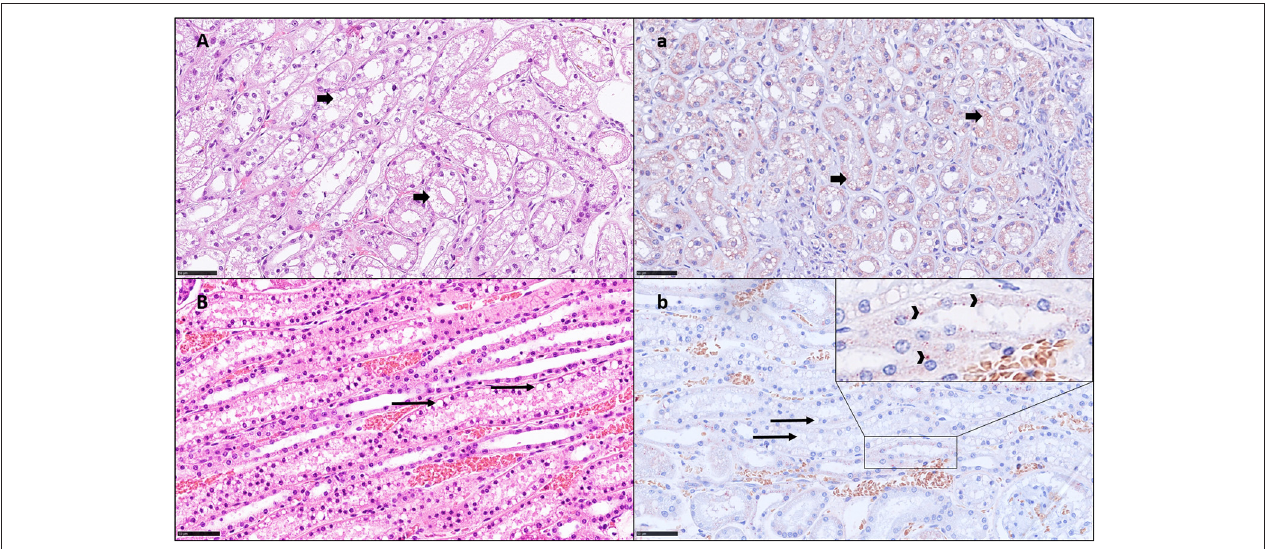
FIGURE 1 | HE histology (A,B) and immunohistochemistry for HES (a,b) showing vacuolation in the kidney tubuli and positivity by HES IHC: A ; a ) Dog no. 20: Grade 3 VAC and ACC, small vacuoles (HE) with positive signal on IHC (short arrows). This kidney shows ON and HES IHC positivity in all segments. B ; b ) Dog no. 12: VAC and ACC Grade 1, with round clear vacuoles, mostly negative on IHC (long arrows) in the proximal tubuli but slightly positive in the distal tubuli (insert, arrow heads) bar = 50 µ